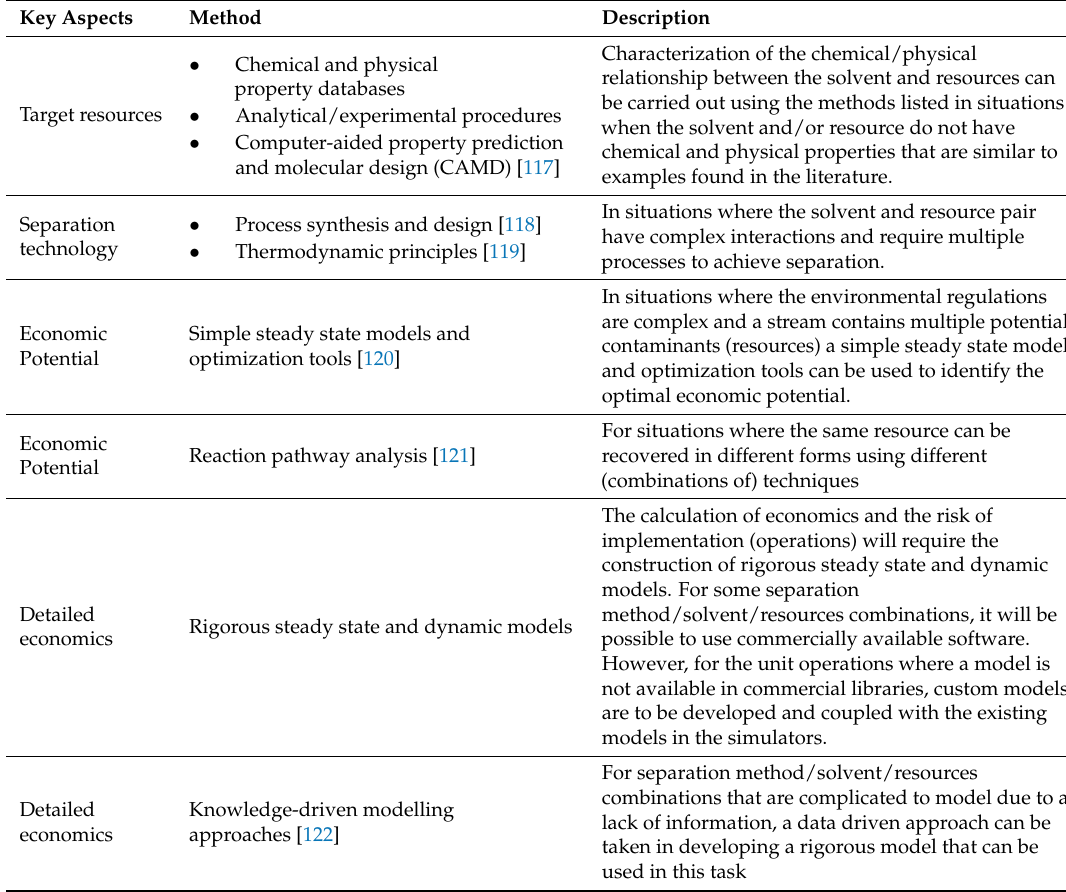
Table 3. Classification of methods for identification of suitable separation techniques for resource